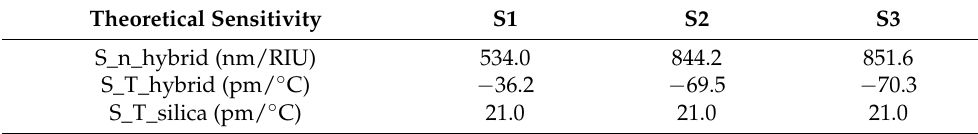
Figure 3. ( a – c ) Reflection spectra of three sensors; ( d ) FFT spectra of three sensors. The RI and temperature sensitivities of these three sensors can be predicted from Equation (5). In this calculation, the medium filled in CF is water, whose RI is n ho = 1.333 and the RI of silica is n si = 1.46. The expansion coefficient and the thermo optic coefficient of silica are α si = 5.5 × 10 − 6 / ◦ C and ξ si = 1.178 × 10 − 5 / ◦ C, respectively [34,35]. The thermo optic coefficient of deionized water is ξ water = − 9.646 × 10 − 5 / ◦ C [36]. The resonant wavelength is 1550 nm. Therefore, the theoretical sensitivities of hybrid and silica cavity of three sensors can be calculated and are shown in Table 2. Table 2. Theoretical sensitivities of three sensors.